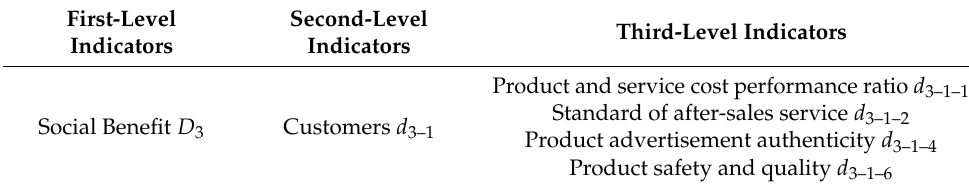
Table 8. Third-level indicators of social benefit D 3 and customers d 3–1 after screening.